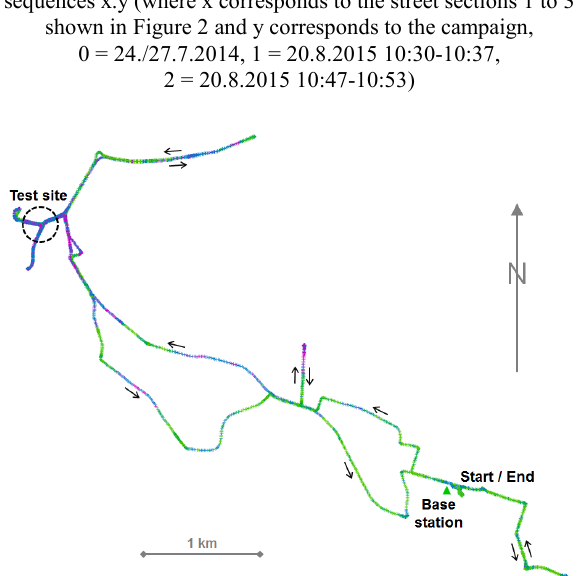
Figure 3. Trajectory of campaign on 20.8.2015 (green: high quality, red: low quality, test site: medium to low quality, trajectory extent in east-west direction is around 4.750